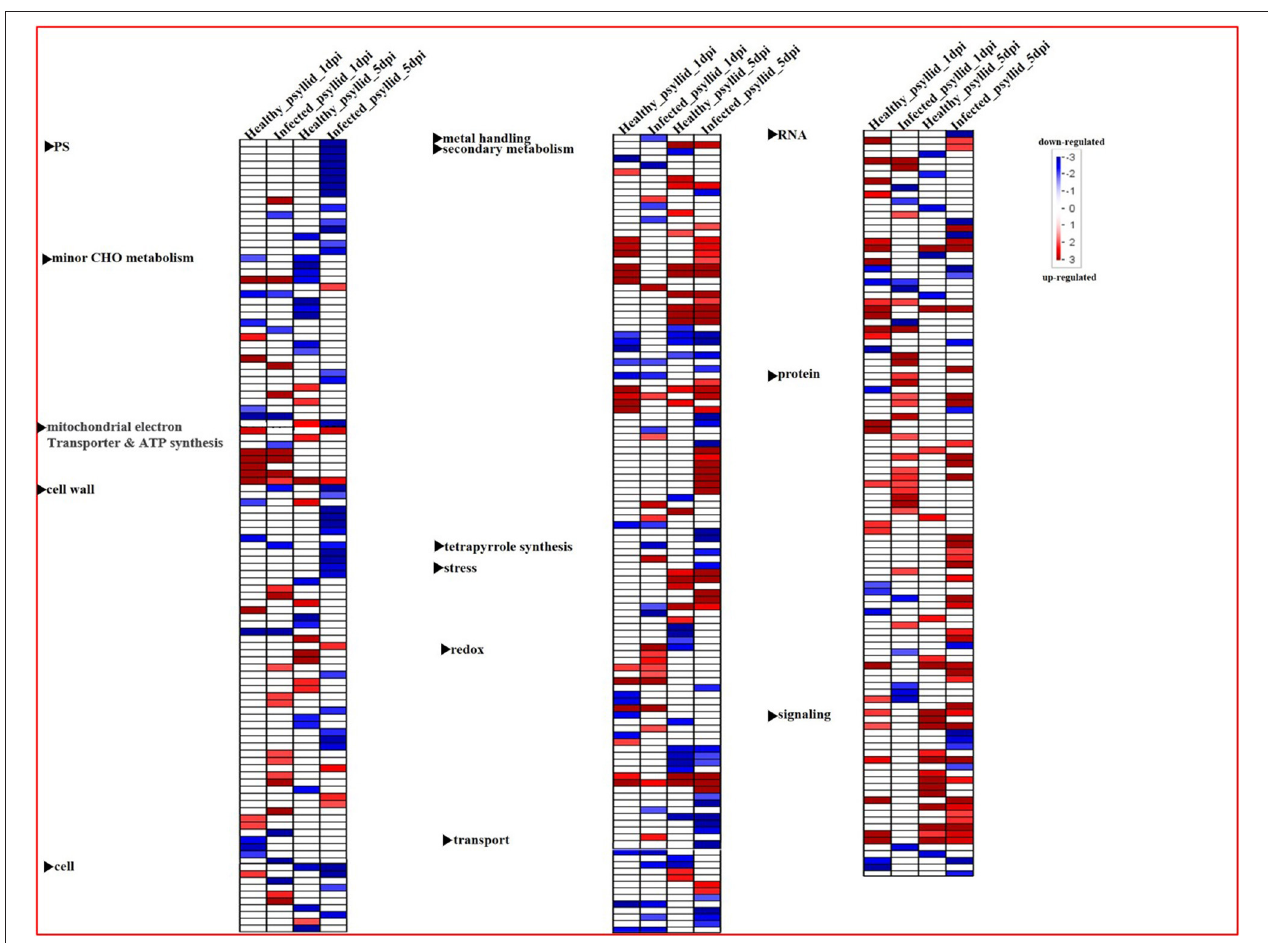
FIGURE 3 | Overview of the significantly affected functional categories in Valencia sweet orange in healthy and Ca Las-infected psyllid treatments at 1 and 5 dpi. Changes in transcript levels are presented as log2 fold changes. The data were subjected to the Wilcoxon test in PageMan, and the results are displayed in false-color code. Bins colored in red are significantly upregulated, whereas bins colored in blue are significantly downregulated. PS, photosynthesis.